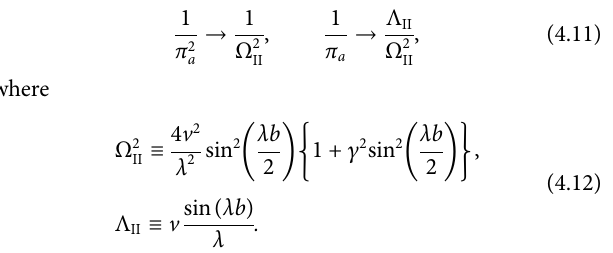
Frontiers in Astronomy and Space Sciences |